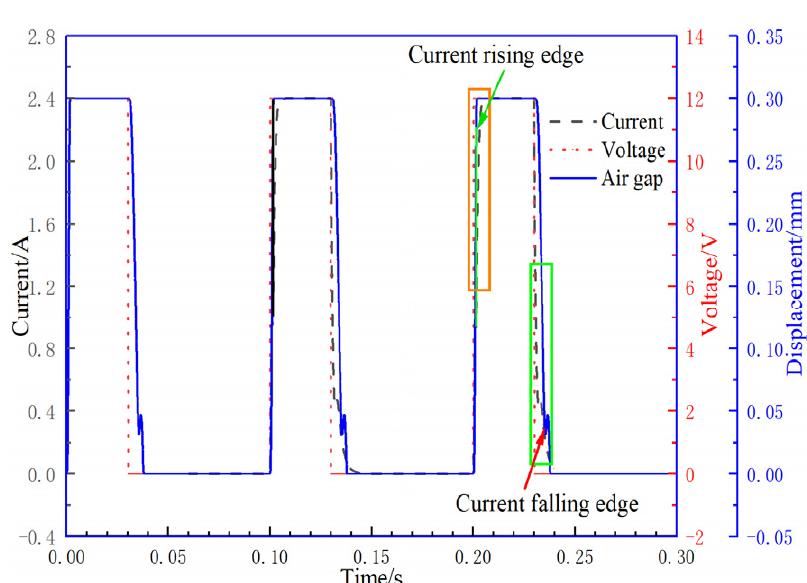
Figure 8. Voltage-current-displacement response curve.